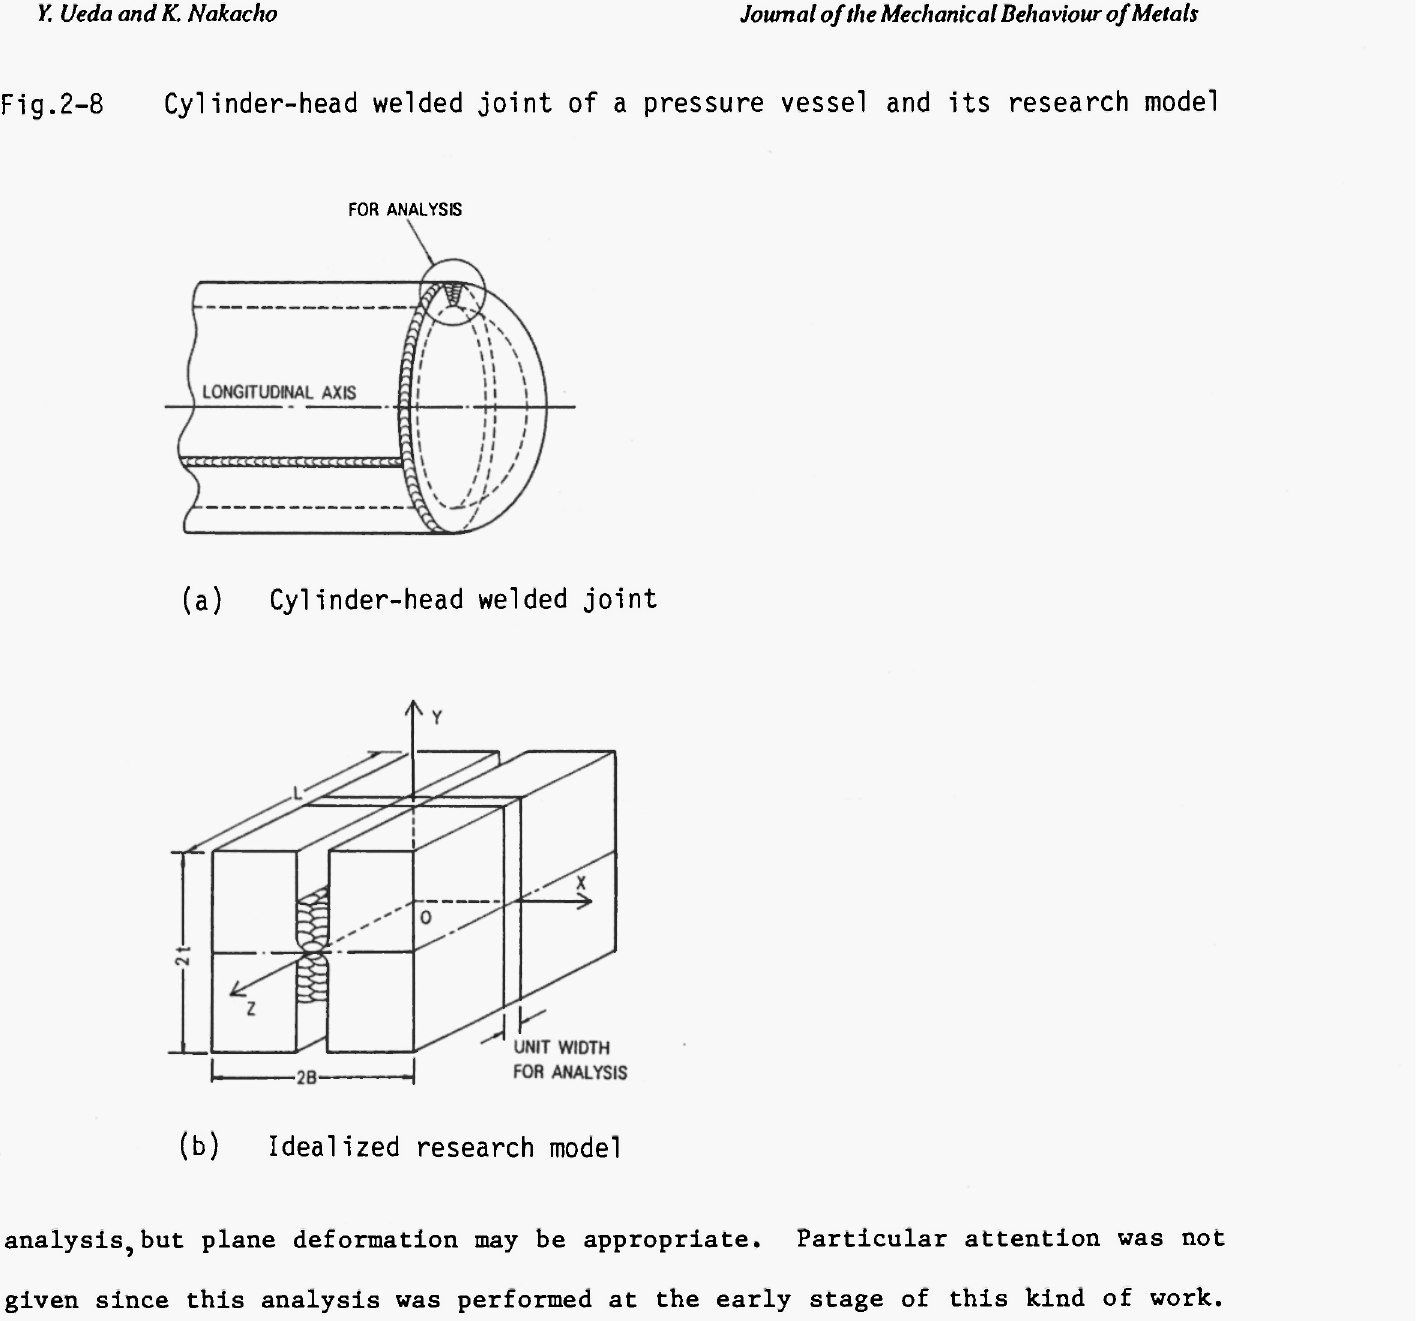
Fig.2-8 Cylinder-head welded joint of a pressure vessel and its research model